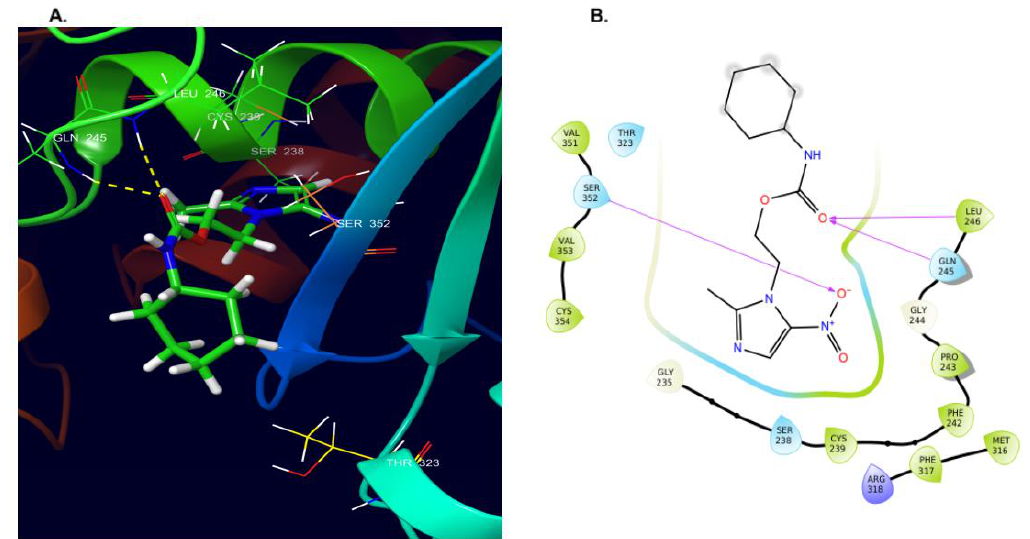
Figure 2. ( A ) 3D and ( B ) 2D representation of the binding model of compound 1 in the vicinity of the colchicine binding site of β -tubulin.